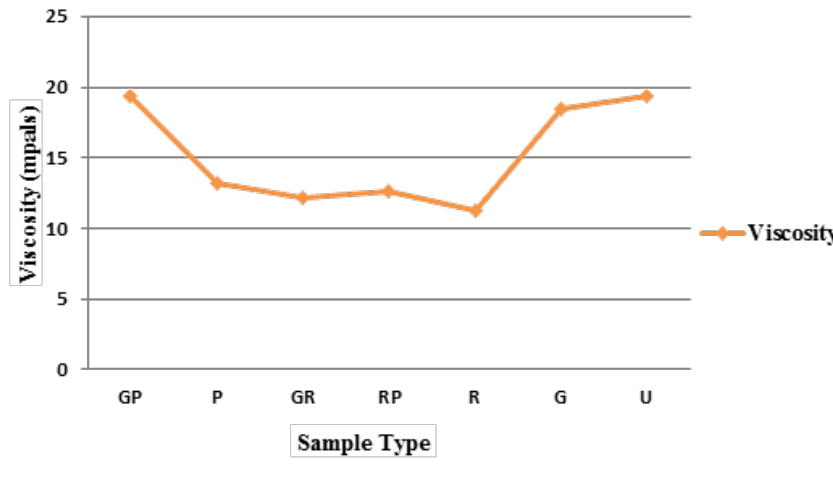
Figure 1: Viscosity of yoghurt from pre-treated Bambara